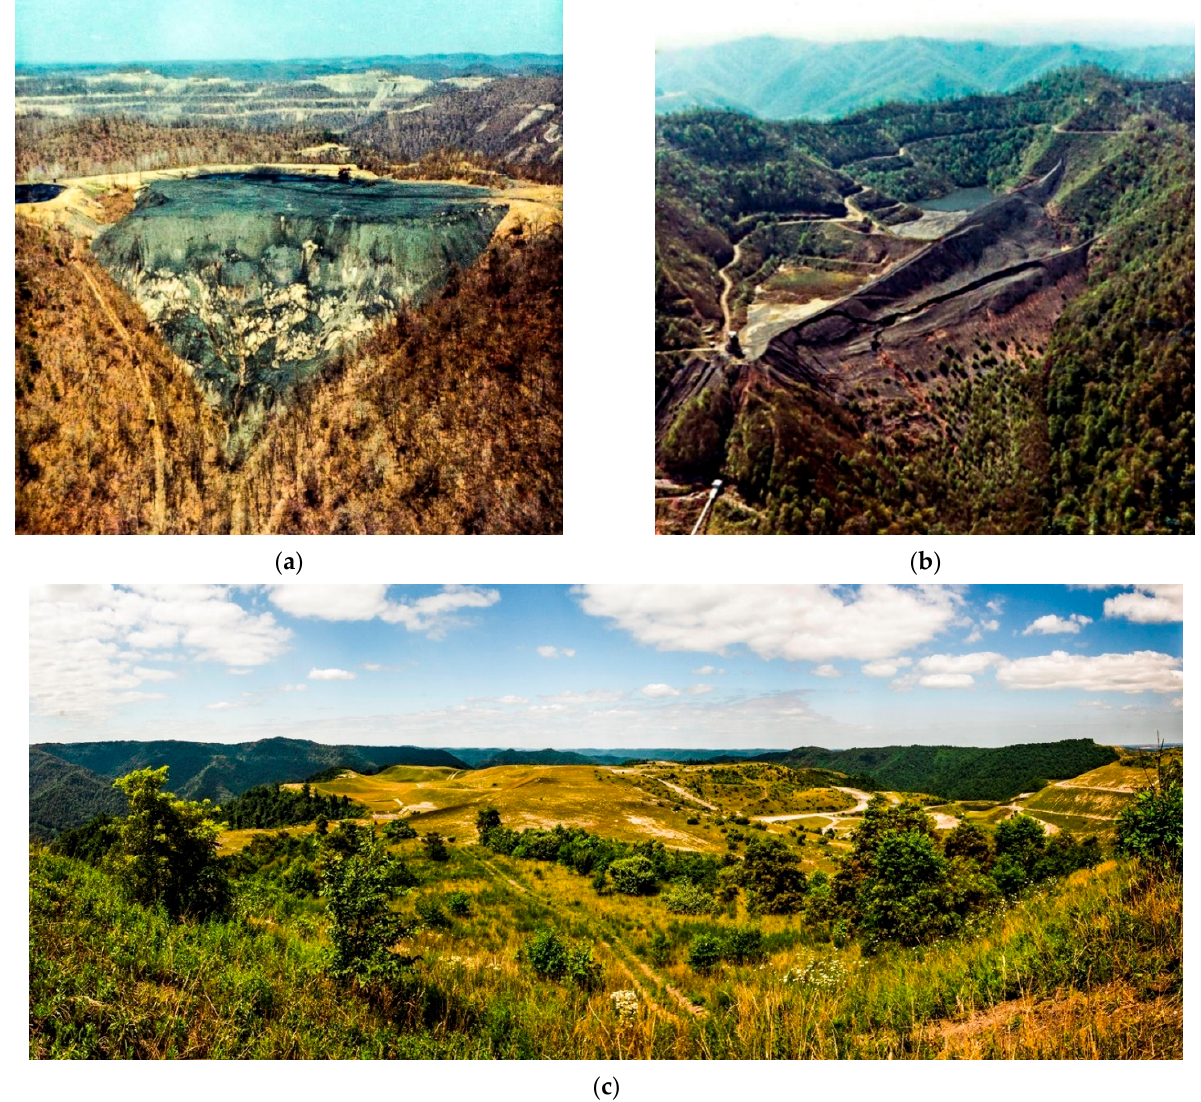
Figure 1. Effects of surface minings and highwall mining in the Appalachian landscape in 1972: ( a ) dump site number 129, Boone County, WV [34]; ( b ) dump site number 253, Wyoming County, WV [34]. ( c ) MTRVF reclaimed landscape: Kayford Mountain, WV, 2018 (photo V. Cribari).